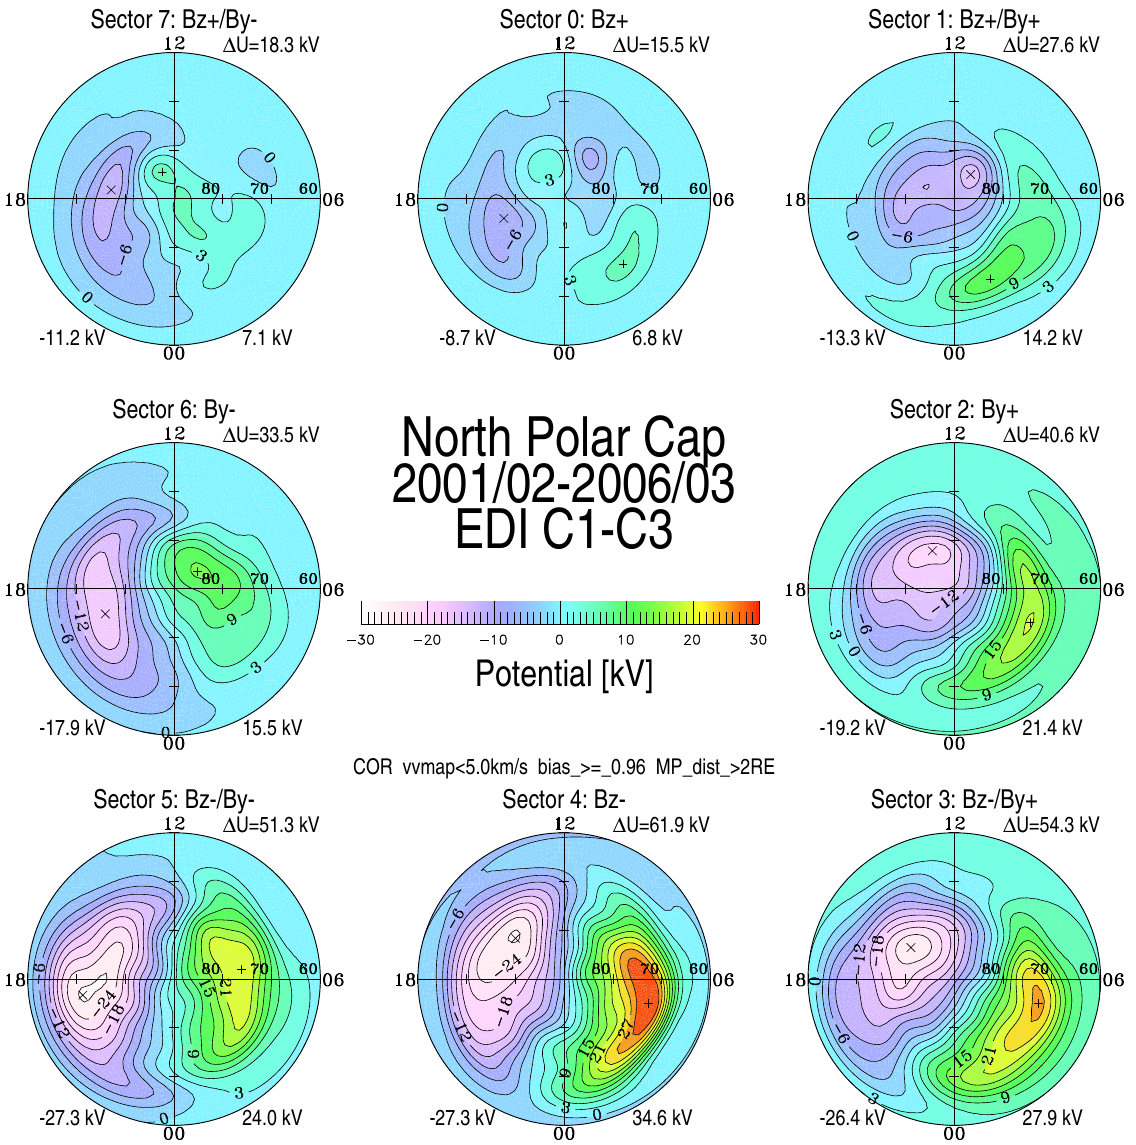
Fig. 7. Electric potentials in the Northern Hemisphere, as a function of AACGM latitude and magnetic local time, for 8 clock-angle orientations of the IMF, obtained by mapping the Cluster EDI velocity measurements into the ionosphere. The background color shows the value of the potential, according to the color bar at the center. Lines are drawn at fixed values of the potential, with a 3kV spacing.The minimum and maximum potentials are listed at the bottom, and the total potential at the upper right of each map.